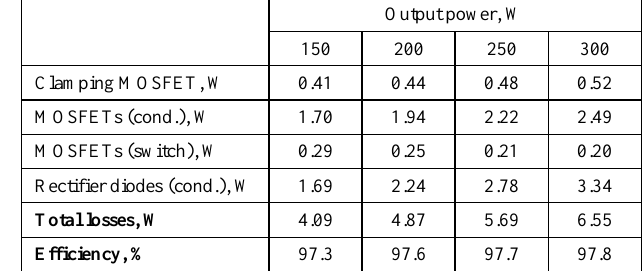
C ALCULATED P OWER L OSSES OF THE Q ZS C